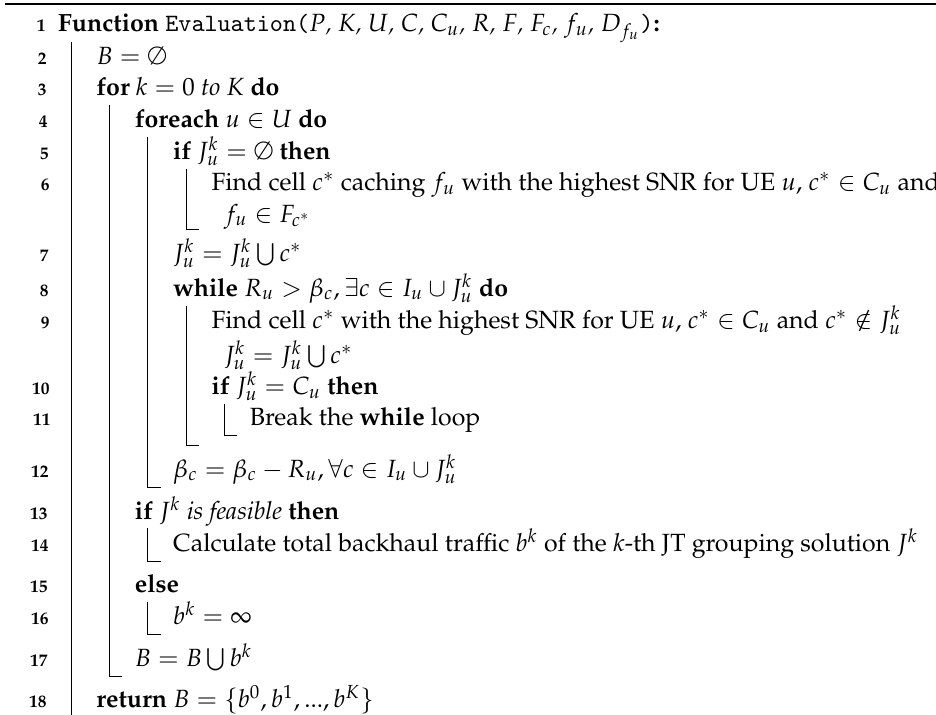
Algorithm 3: Evaluation()